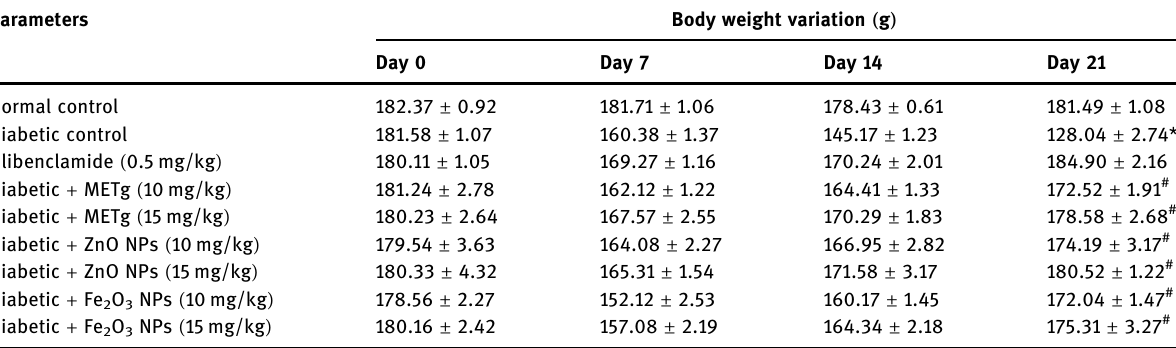
Table 2: E ff ect of T. glabra methanolic extract, and their mediated ZnO NPs and Fe 2 O 3 NPs on body weight of experimental animals